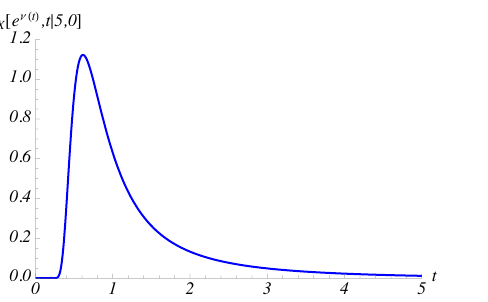
Figure 5. The FPT density (20) through the carrying capacity S 1 ( t ) = e ν ( t ) is plotted for the same choices as Figure 1 with x 0 = 5 and σ 2 ( t ) = 2